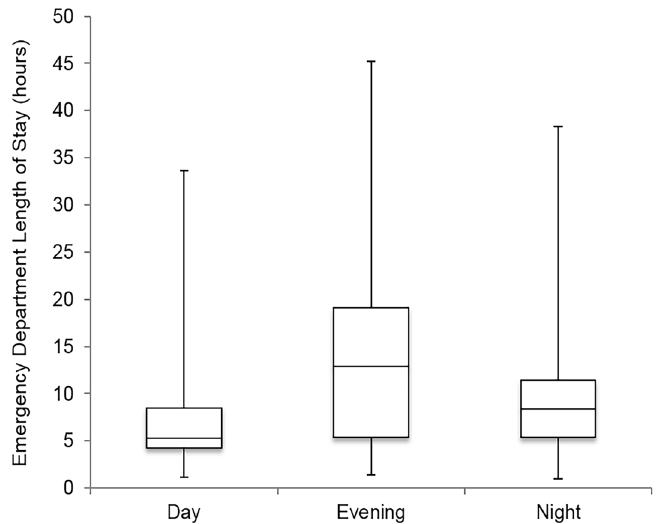
Figure 3. Emergency department length of stay by time of presentation. Box and whisker plots representing median emergency department length of stay with inter-quartile ranges for n=3,164